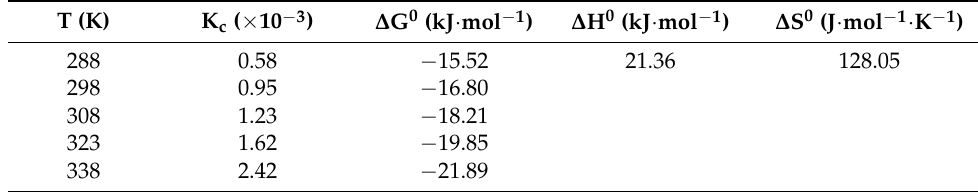
Table 5. The calculated thermodynamic